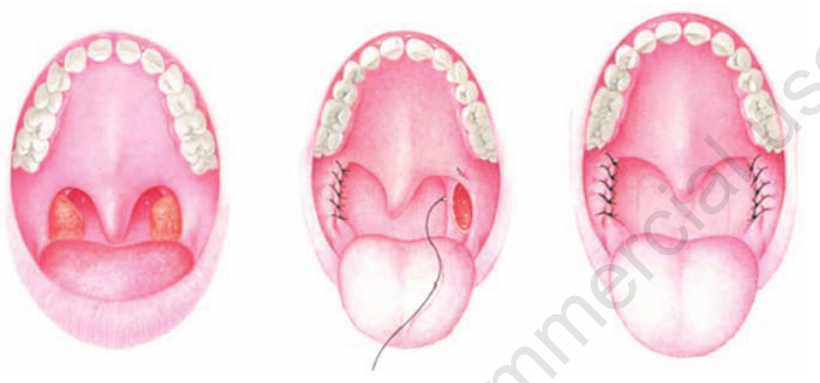
Figure 3. Reprinted with permission of the American Thoracic Society. Copyright (c) 2011 American Thoracic Society. Won C, Li K, Guilleminault C. Surgical treatment of obstructive sleep apnea: upper airway and maxillomandibular surgery. Proc Am Thorac Soc. 2008; 5: 193–199. Official Journal of the American Thoracic Society.